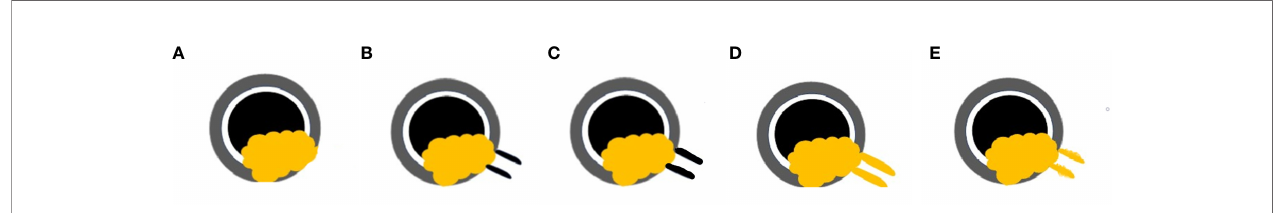
FIGURE 2 | The MRI – detected EMVI (mrEMVI) scoring system. Score 0 (A) : De fi nitely negative(No vessels adjacent to areas of tumor penetration); Score 1 (B) : Probably negative (Minimal extramural stranding/nodular extension, but not in the vicinity of any vascular structure); Score 2 (C) : Possibly negative (Stranding demonstrated in the vicinity of extramural vessels, but these are of normal caliber, and no de fi nite tumor signal in vessel); Score 3 (D) : Probably positive (Intermediate signal intensity apparent within the vessels, although contour and caliber of these vessels are only slightly expanded; Score 4 (E) : De fi nitely positive (Obvious irregular vessel contour or nodular expansion of vessel by de fi nite tumor signal).